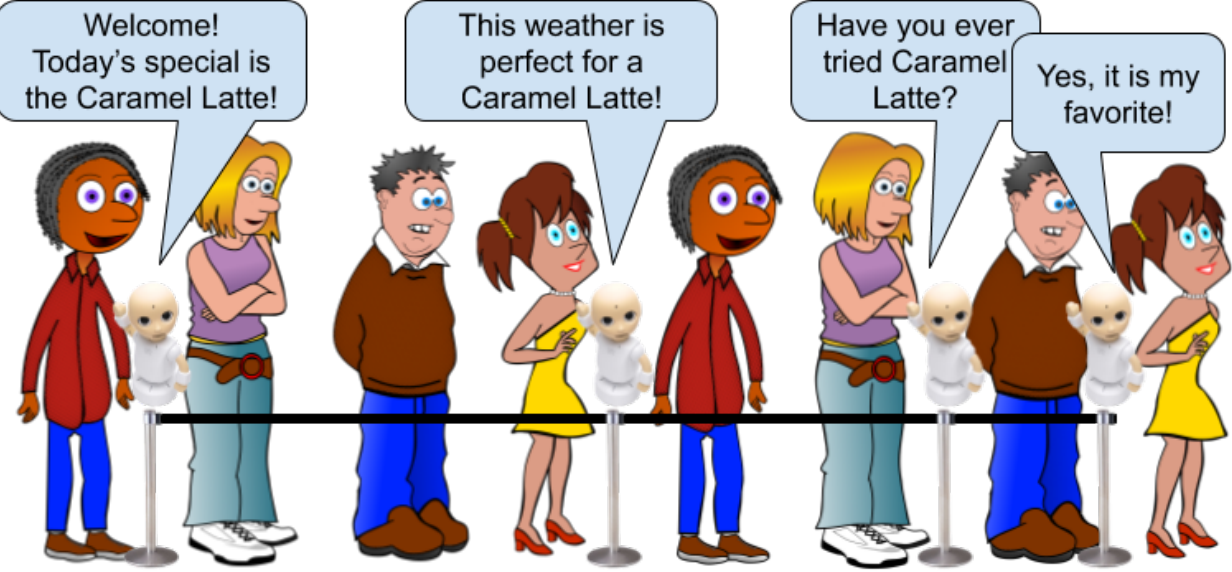
Figure 2. Example of possible implementation of sequential persuasion in a coffee shop line to promote a specific